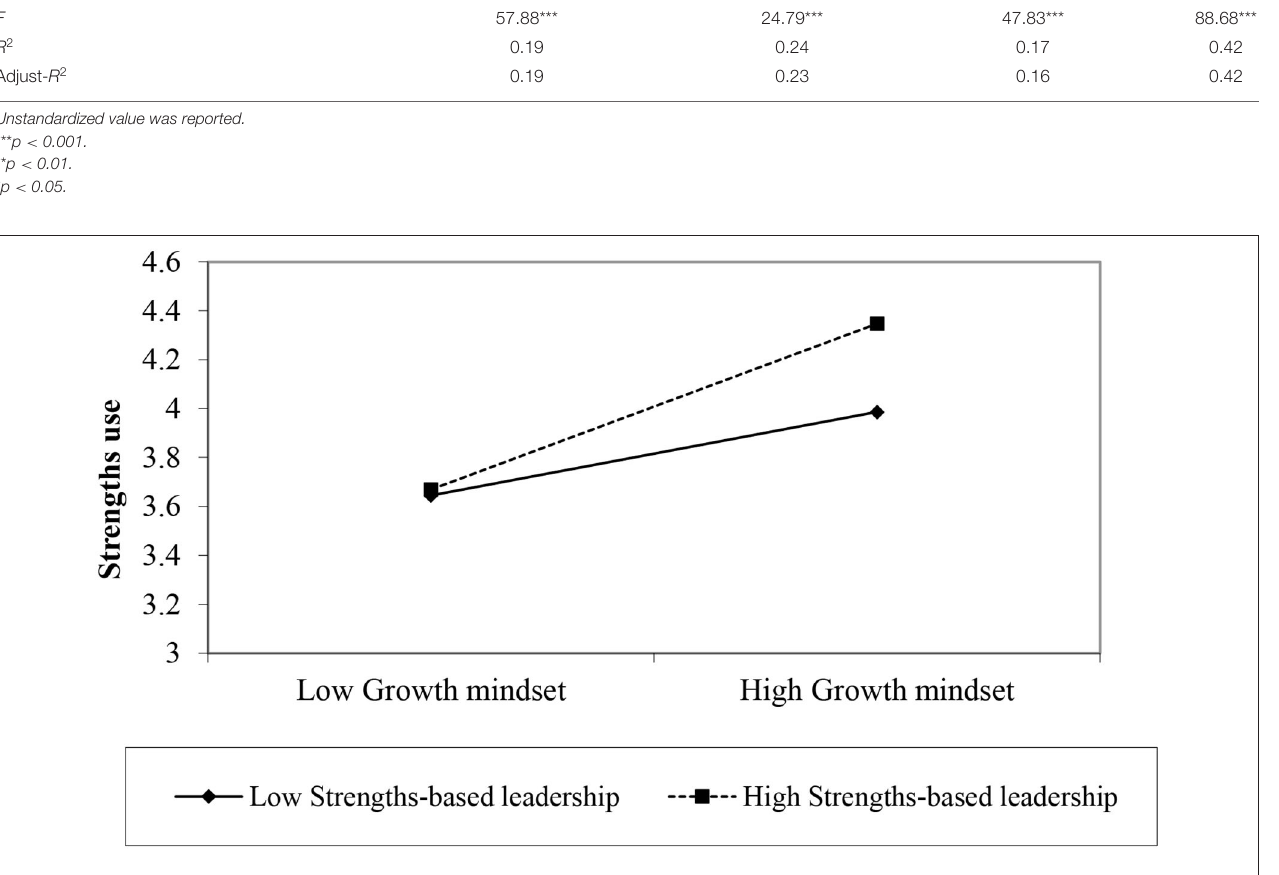
FIGURE 2 | Plot of interactive